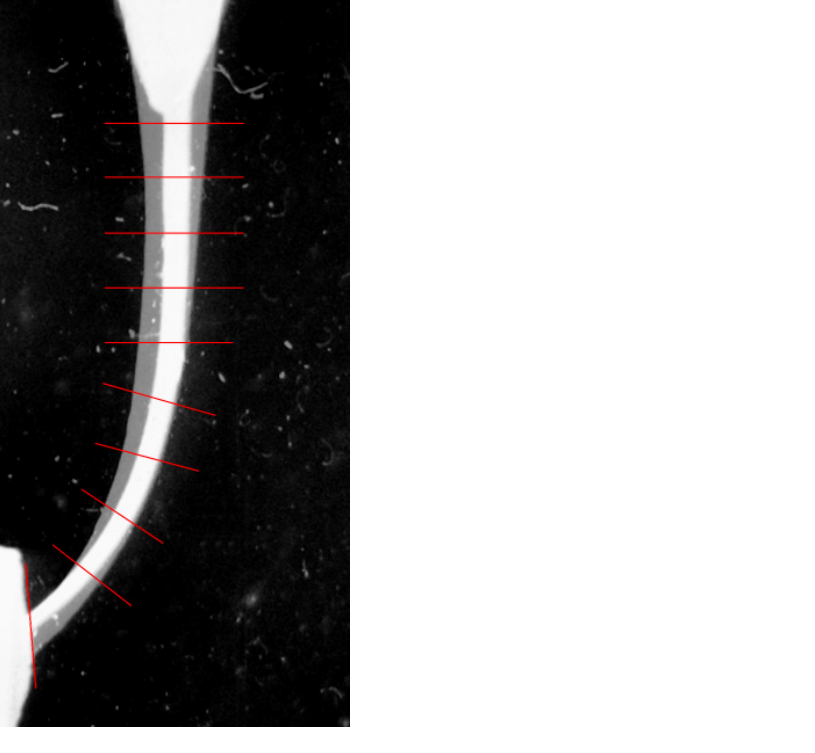
Figure 2. Illustration of the measurement points, measured every 1 mm, perpendicular to the axis of the duct.